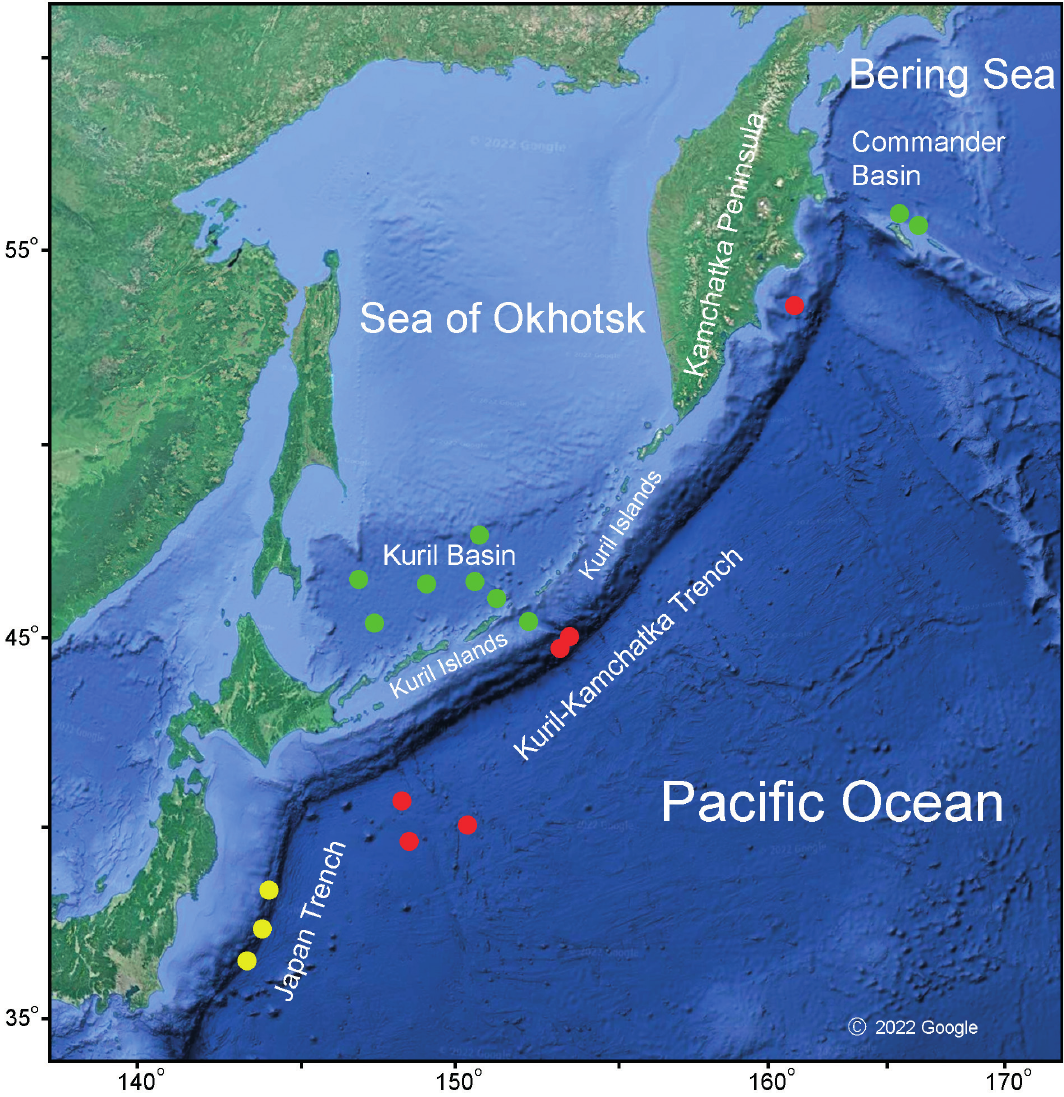
Fig. 6. The location of stations where the new species of Thyasiridae were found . Parathyasira coani sp. nov. (red spots); Parathyasira pauli sp. nov. (yellow spots); Thyasira kharkovensis sp. nov. (green spots). (Map data © 2022